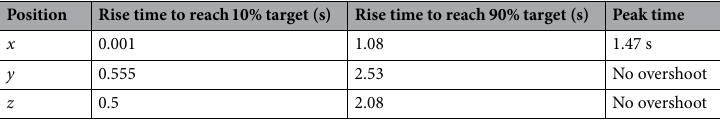
Table 7. Transient response time of the experimental setting.